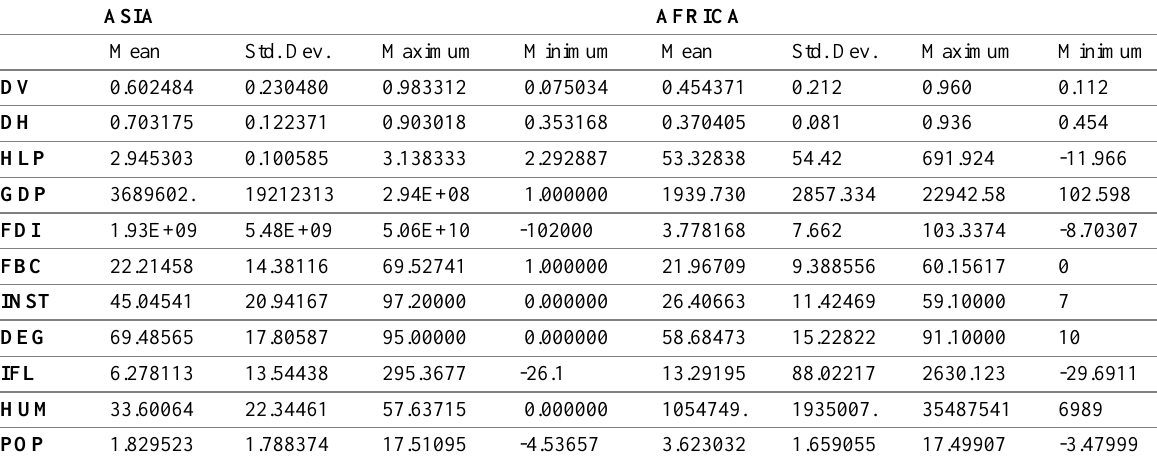
Table 2: Descriptive for the two country